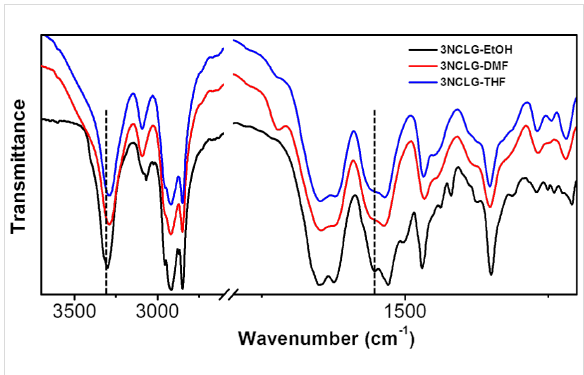
Figure 8: FTIR spectra of the 3NCLG assembly in ethanol (black), in DMF (red) and in THF